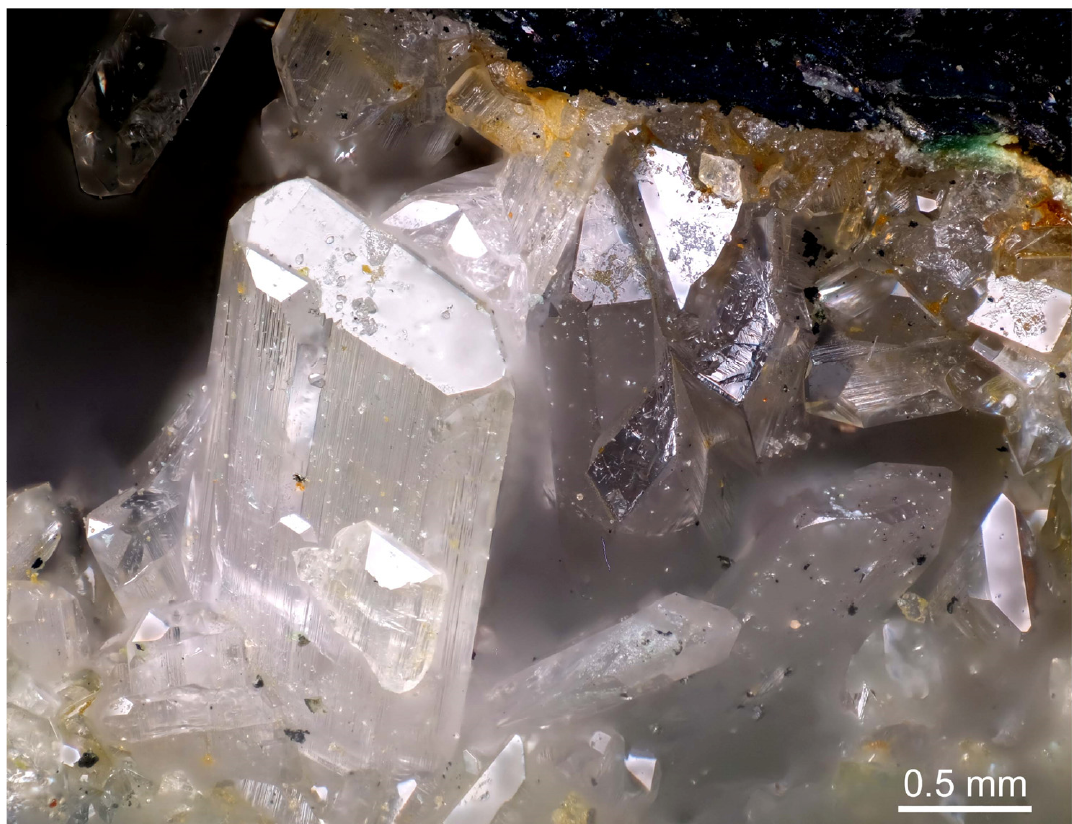
Figure 2. Optical image of well-developed colourless anglesite crystals from the Mastricarro Barite Mine (Catanzaro, Southern Italy).